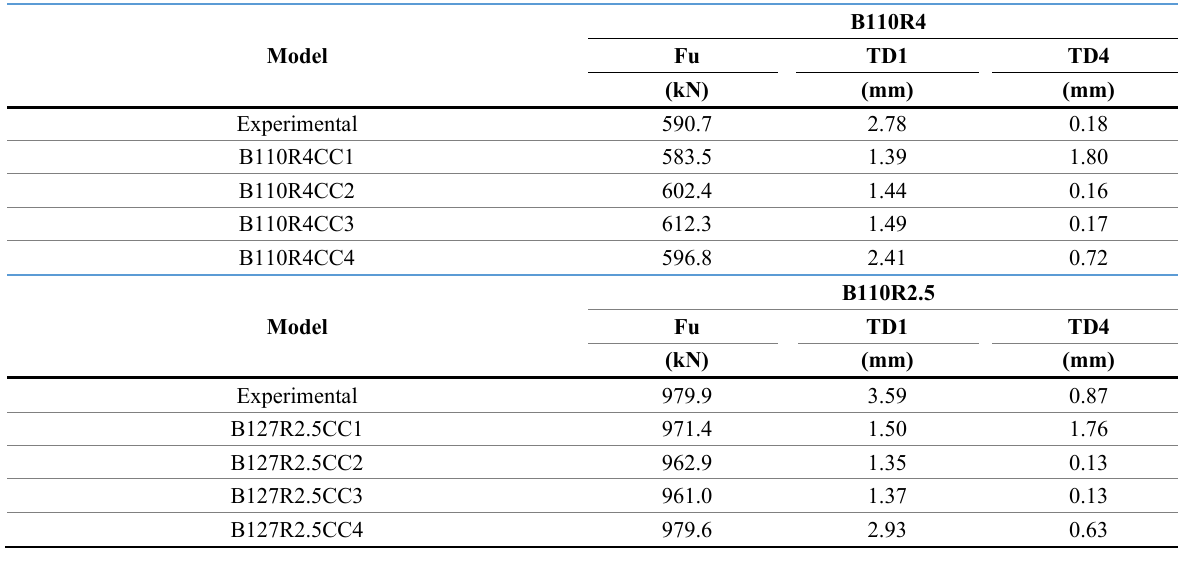
Table 3. Results for failure loads and displacement in transducers of experimental and numerical models with variation in pile